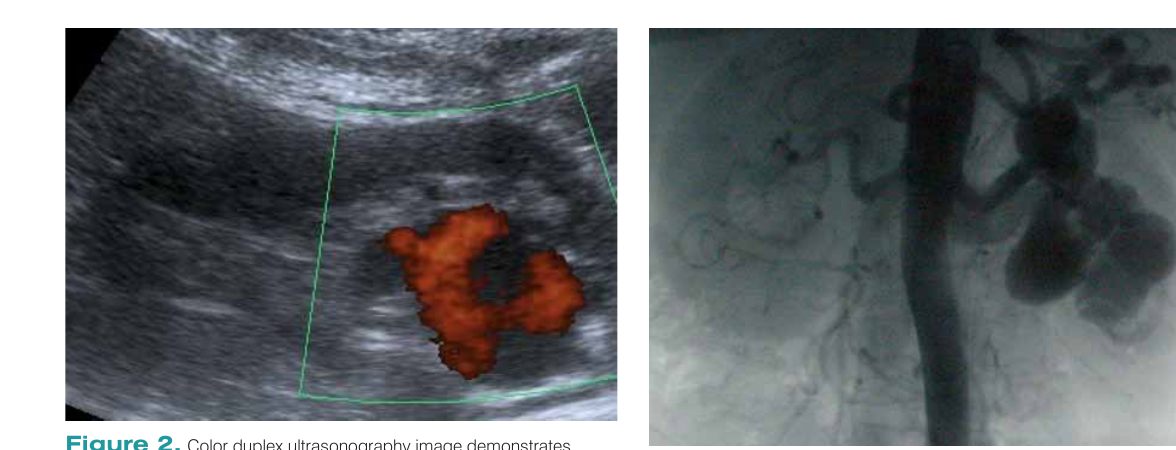
Figure 4. Arteriography showing wide AVF between renal artery and upper interlobar vein.